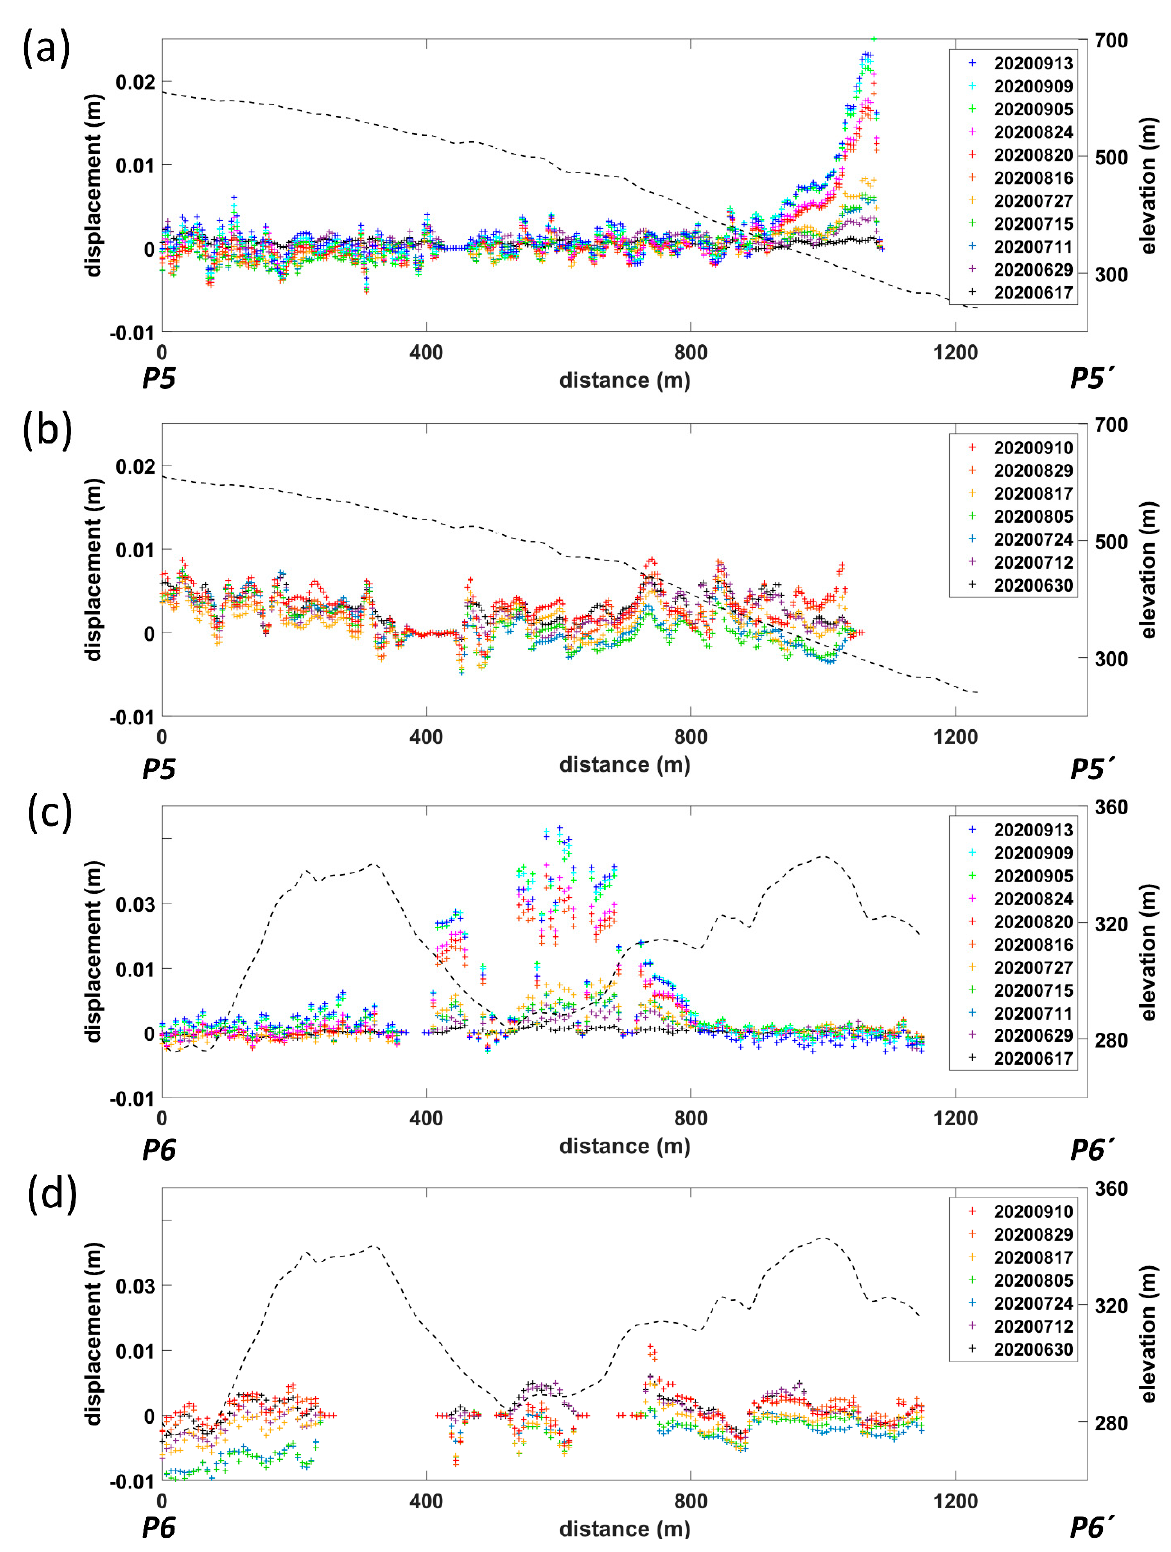
(cid:48) profile, ( b ) Sentinel-1 P5-P5